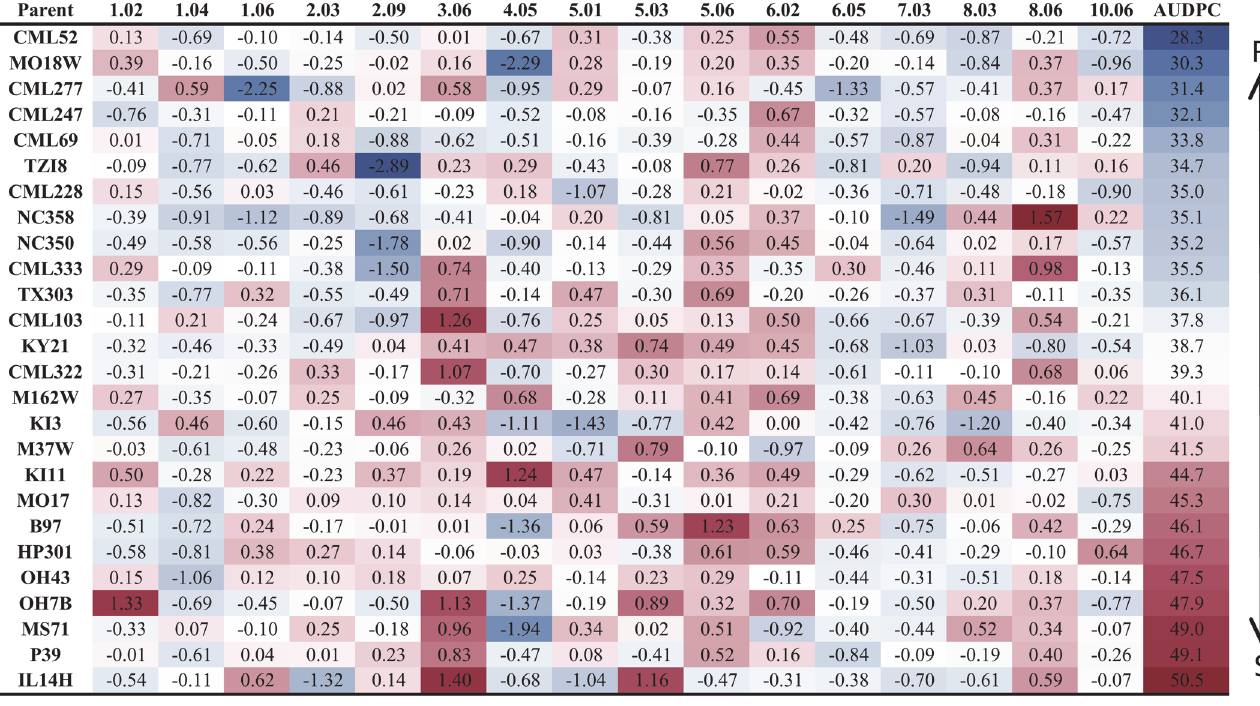
Fig 1. Parental allelic effects at quantitative trait loci. The bin number is listed in the respective column header between the first and last columns. Two sets of data are presented in this figure. Estimated allelic effects relative to the B73 allele of parental lines at qGLSbin for relative change in disease are listed. The values in the table are the coefficients of the general linear model parameter while the color coding is indicative of area under the disease progress curve. R = resistant; S = susceptible.